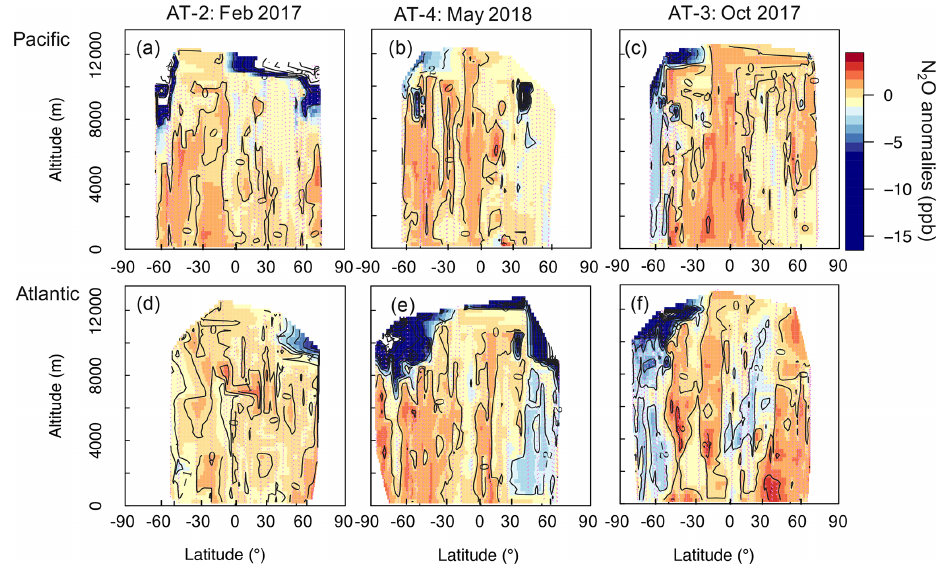
Figure 3. Cross-sections of N 2 O anomalies (ppb) representing the differences between the airborne N 2 O (10s resolution) and the surface N 2 O mixing ratios, interpolated to 0.25 ◦ latitude and 250m altitude for each deployment. Shown are the N 2 O anomalies over (a) – (c) the Pacific and (d) – (f) the Atlantic, with each column representing a deployment (ordered by season: ATom-2, -4, and -3). The color scale ranges from − 15 to 5ppb. Values between − 50 and − 15ppb, observed at the highest altitudes ( > 10km), are shown in white to allow better visualization of small changes in positive anomalies. Lilac dashed lines represent the flight tracks. Black contours are areas of N 2 O